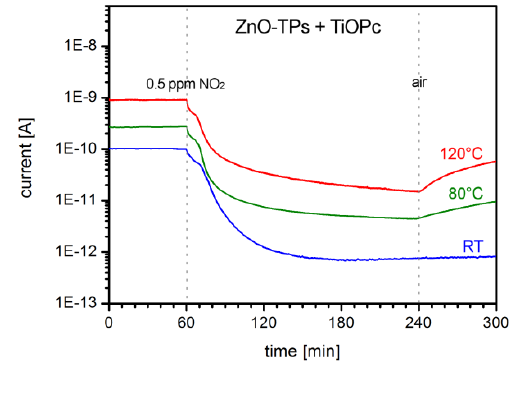
Figure 9. Plot of the dynamic response of a ZnO-TPs+TiOPc gas sensor towards 0.5 ppm of NO at room temperature (RT), 80 °C and 120 °C (RH 30%). Recovery time increases 2 with